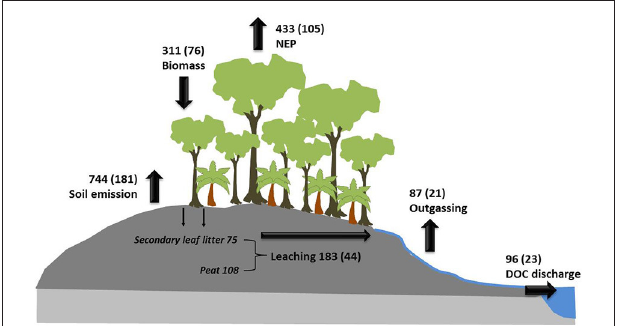
FIGURE 5 | Carbon fluxes in disturbed peatlands. Net ecosystem carbon losses representing a negative net ecosystem production (NEP; Hirano et al., 2007), CO 2 emissions from disturbed peat soils due to aerobic peat decomposition (Miettinen and Liew, 2010) and fires (van der Werf et al., 2008), carbon leaching, outgassing, and DOC discharge into the ocean. The carbon uptake by the growing biomass results from the difference between soil emission and NEP. River outgassing is the difference between leaching and DOC discharge into the ocean. The numbers and the numbers in brackets are fluxes in g C m − 2 yr − 1 and Tg C yr − 1 ,